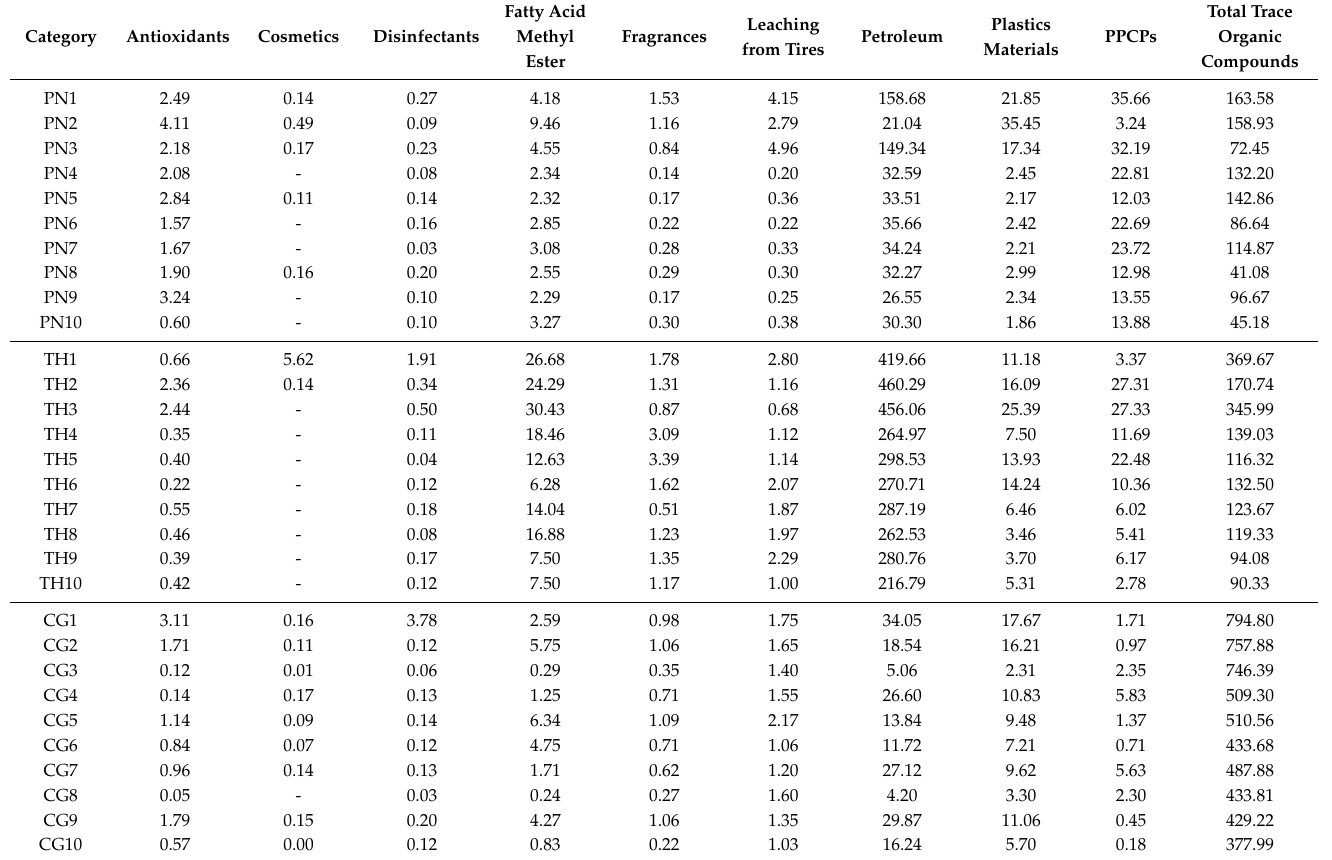
Table 2. The concentration of trace organic compounds originating from business/household/traffic (ng.m − 3 ) and total trace organic